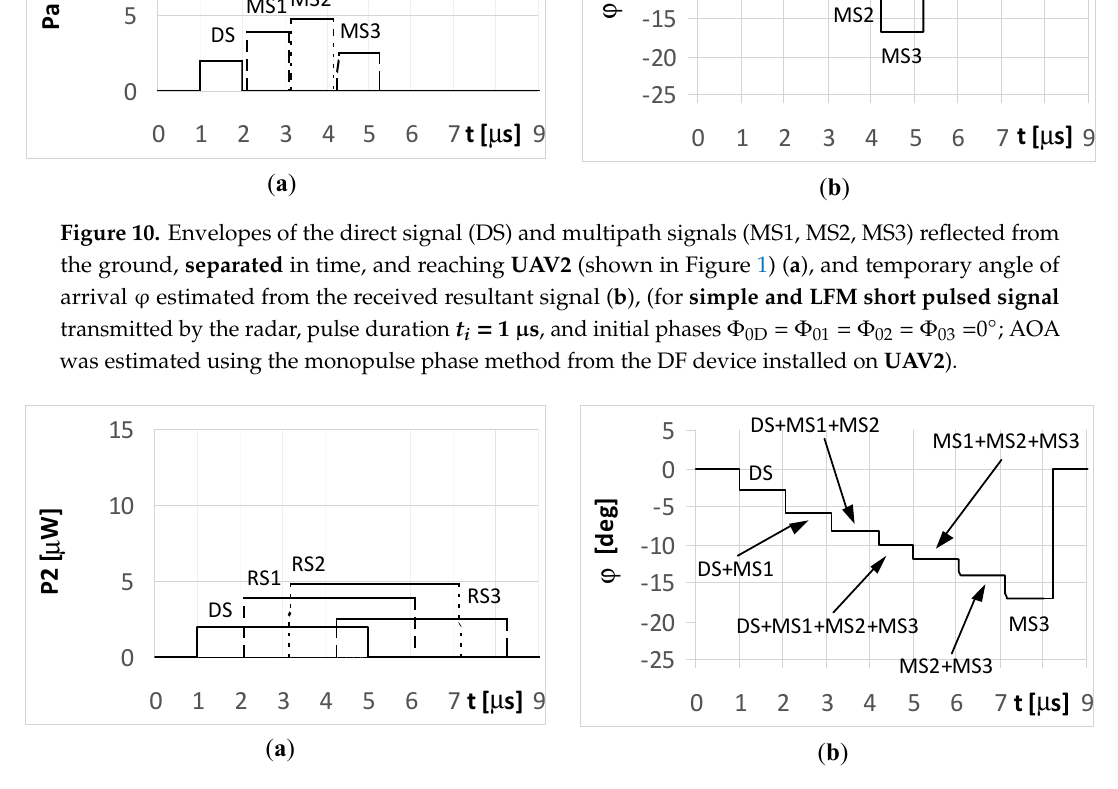
Figure 11. Envelopes of the direct signal (DS) and multipath signals (MS1, MS2, MS3) reflected from the ground, overlapping in time, and reaching UAV2 (shown in Figure 1) ( a ), and temporary angle of arrival ϕ estimated from the received resultant signal ( b ), (radar transmits simple long pulsed signal with duration t i = 4 μ s , and initial phases Φ 0D = Φ 01 = Φ 02 = Φ 03 = 0 ° ; AOA was estimated using the monopulse phase method from the DF device installed on UAV2 ).